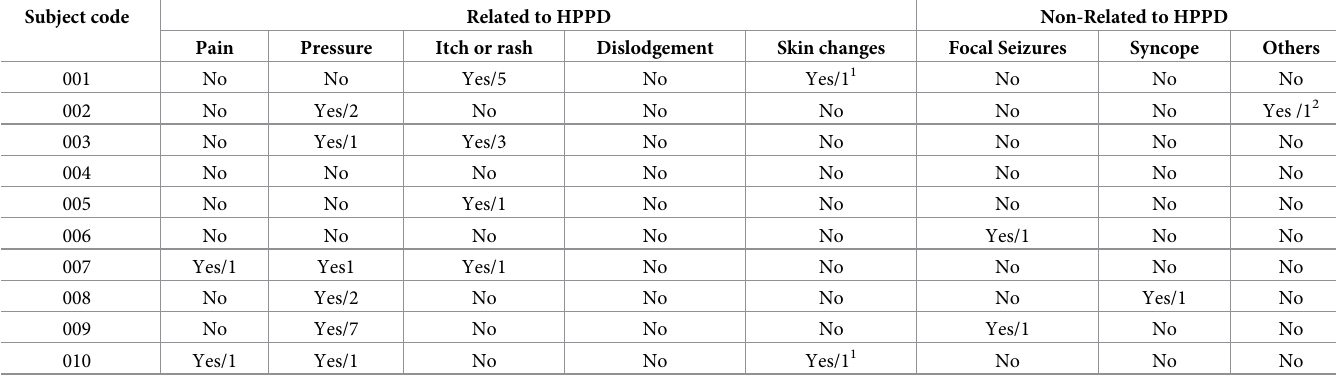
Table 4. Summary of types and number of reported adverse events (N = 10).